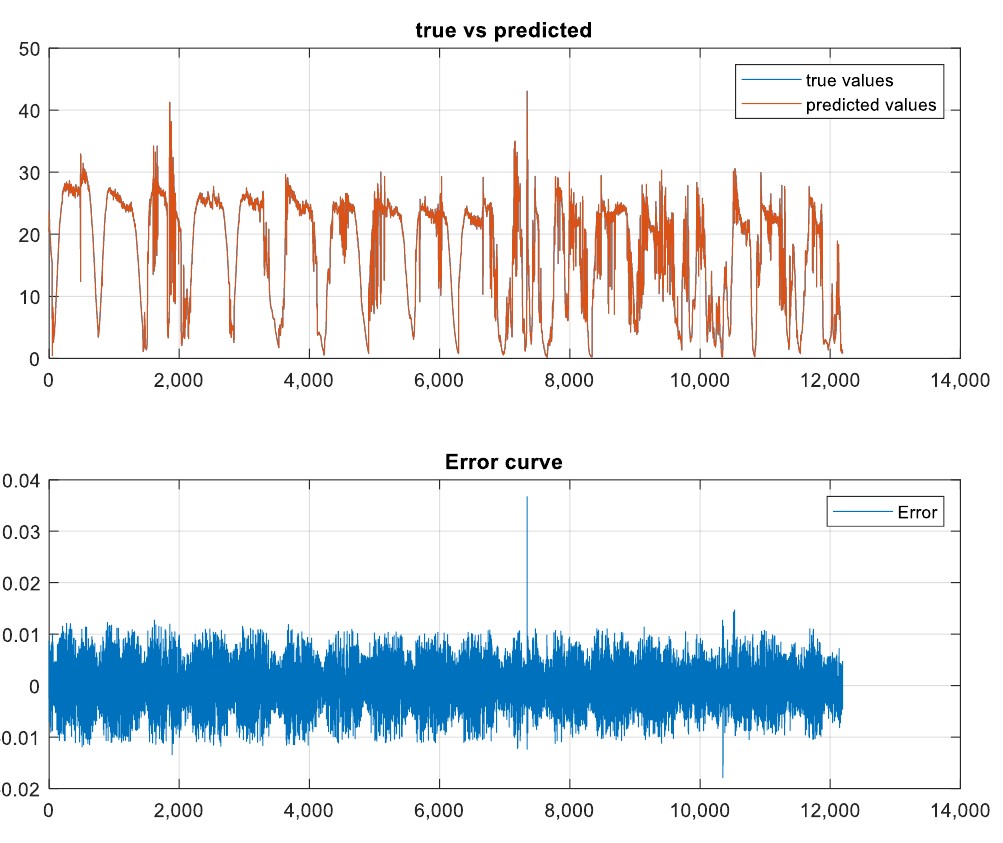
Figure 5. Error and output of ANN results on real data. Table 1. The cost function process of the